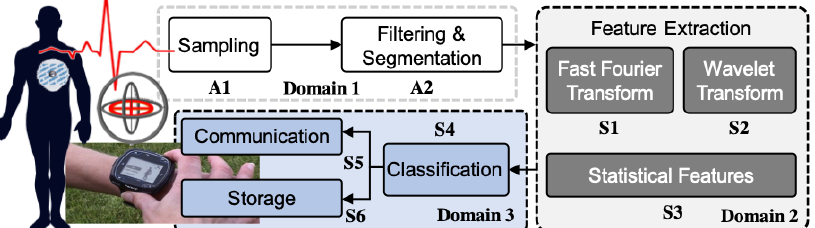
Figure 1. A sample activity monitoring application with three VF domains. Modules A1 and A2 continuously sample and process data, while the other modules become active only when a data frame is